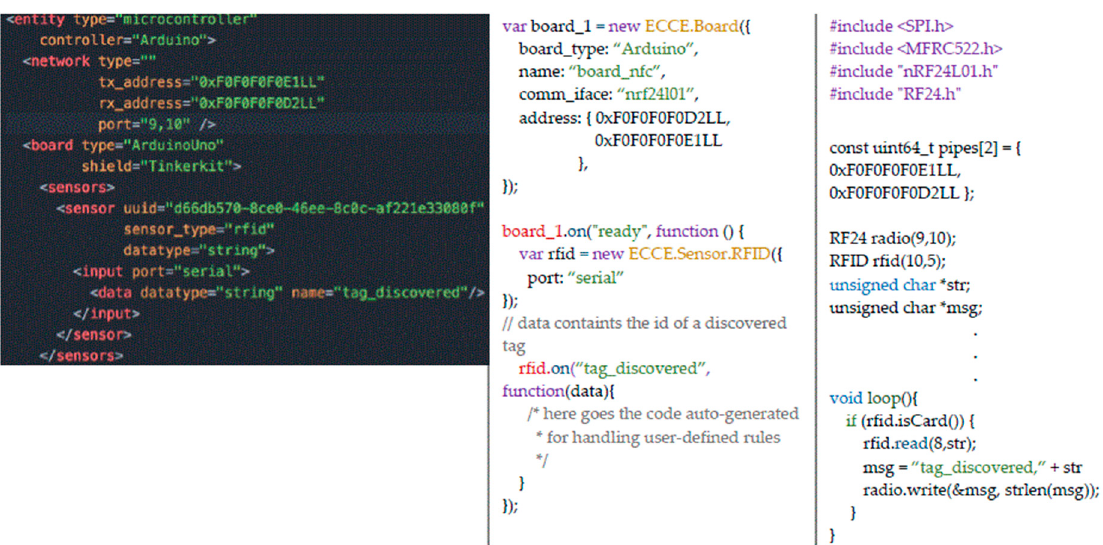
Figure 10. An example of the code to extend the toolkit’s functionality and include a RFID reader input device. On the right, the XML descriptor of an entity with a RFID reader. In the middle, the JavaScript code that is generated by parsing the XML descriptor. On the right, the custom Arduino code for the RFID reader.